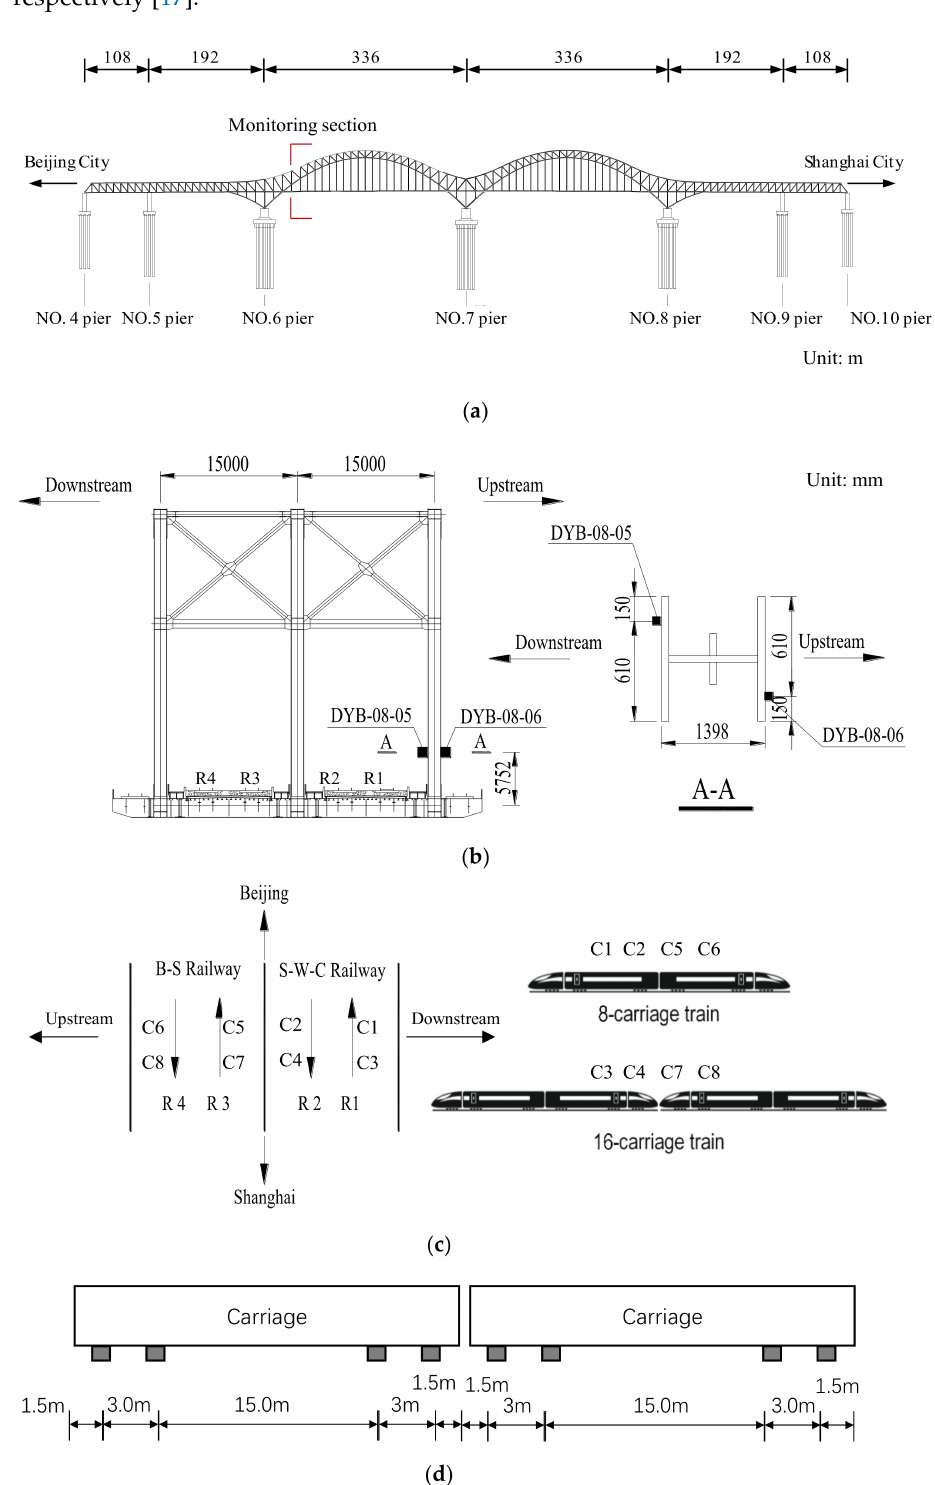
Figure 2. Dashengguan Yangtze River High-speed Railway Bridge; ( a ) side view; ( b ) monitoring section; ( c ) eight traffic cases; ( d ) distance distribution of wheel